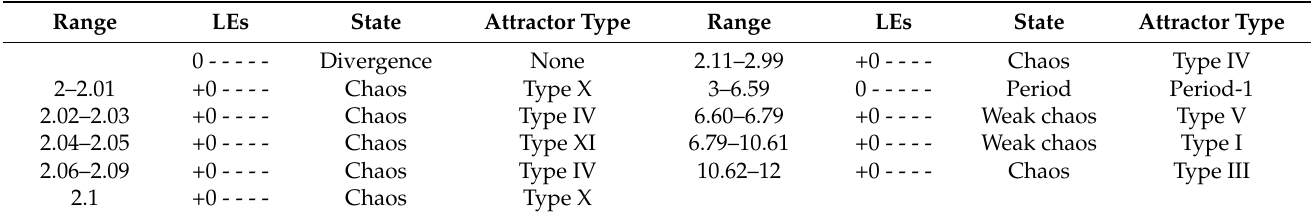
Table 2. Corresponding state and LEs with the initial conditions (1, 1, 1, 1, 1), the parameters a = 10, b = 2, e = 5 , d = 21, k = 3, g = 1.15 and the different parameter c